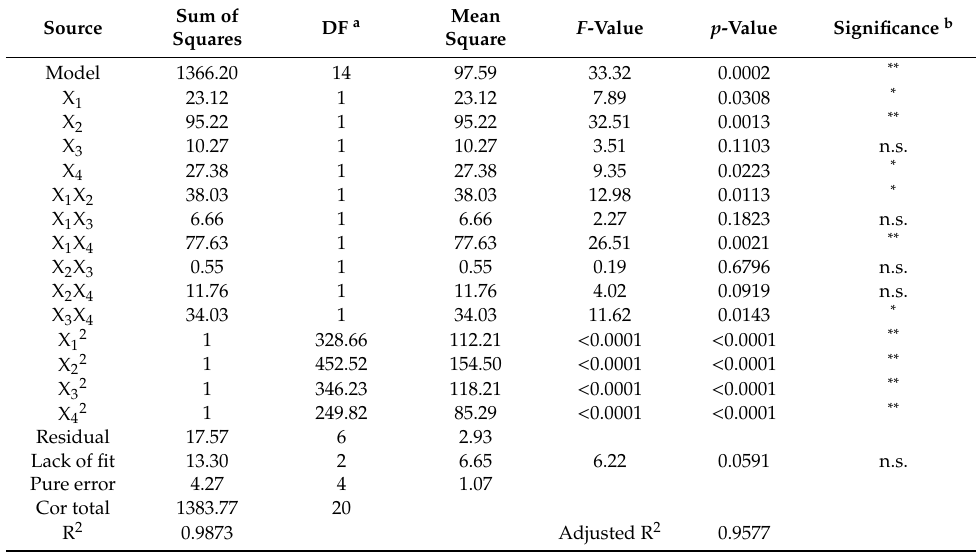
Table 2. ANOVA for response surface quadratic